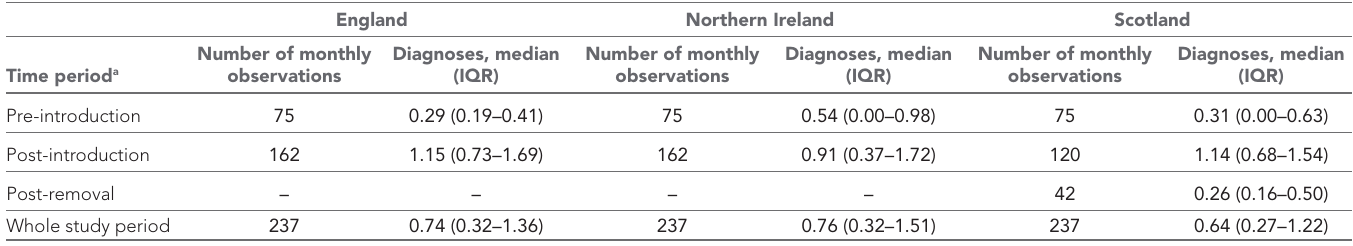
Table 1 Monthly resolved atrial fibrillation (AF) diagnoses per 1000 AF diagnoses across time periods and for whole study period by